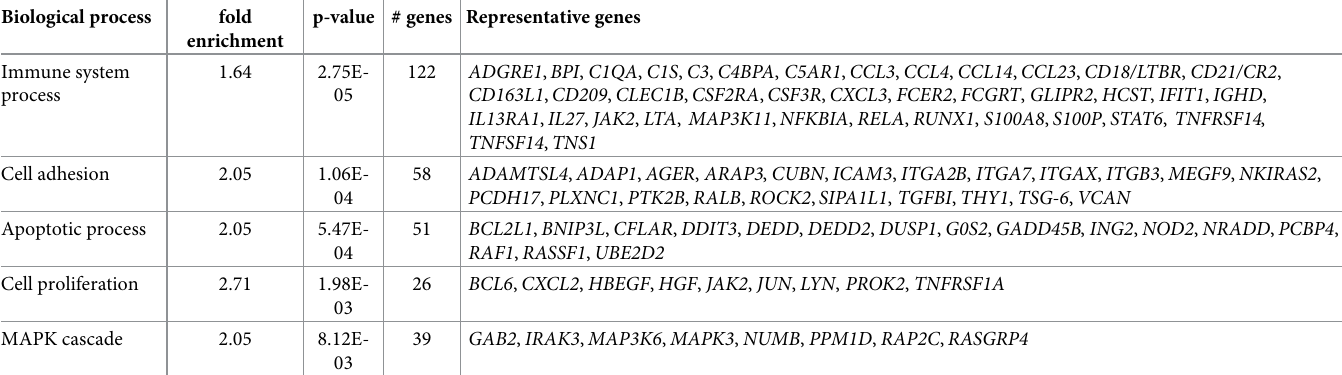
Table 3. Gene enrichment analysis of 1,383 genes with statistically significant decreased expression in foal samples between days 1 and 42. Biological process fold p-value # genes Representative genes enrichment